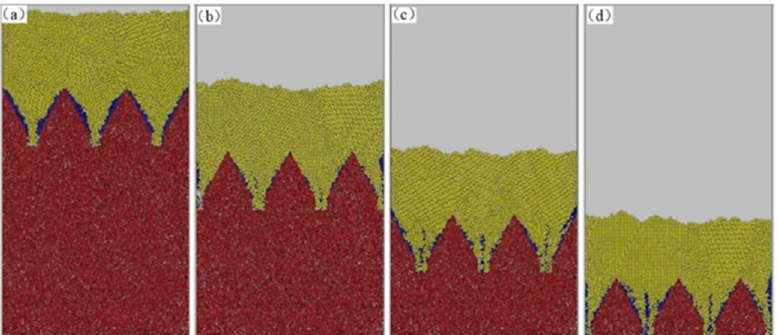
Figure 4. Numerical simulation of ore drawing process: ( a ) subparagraph 1; ( b ) subparagraph 2; ( c ) subparagraph 3; ( d ) subparagraph 4.